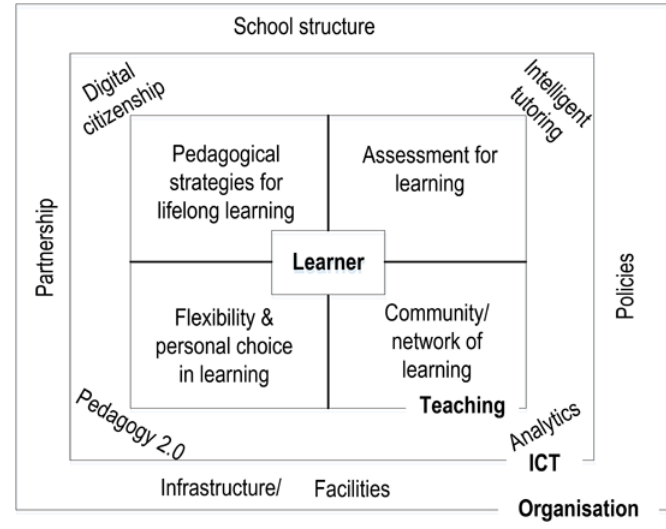
Figure 1 Framework for personalised